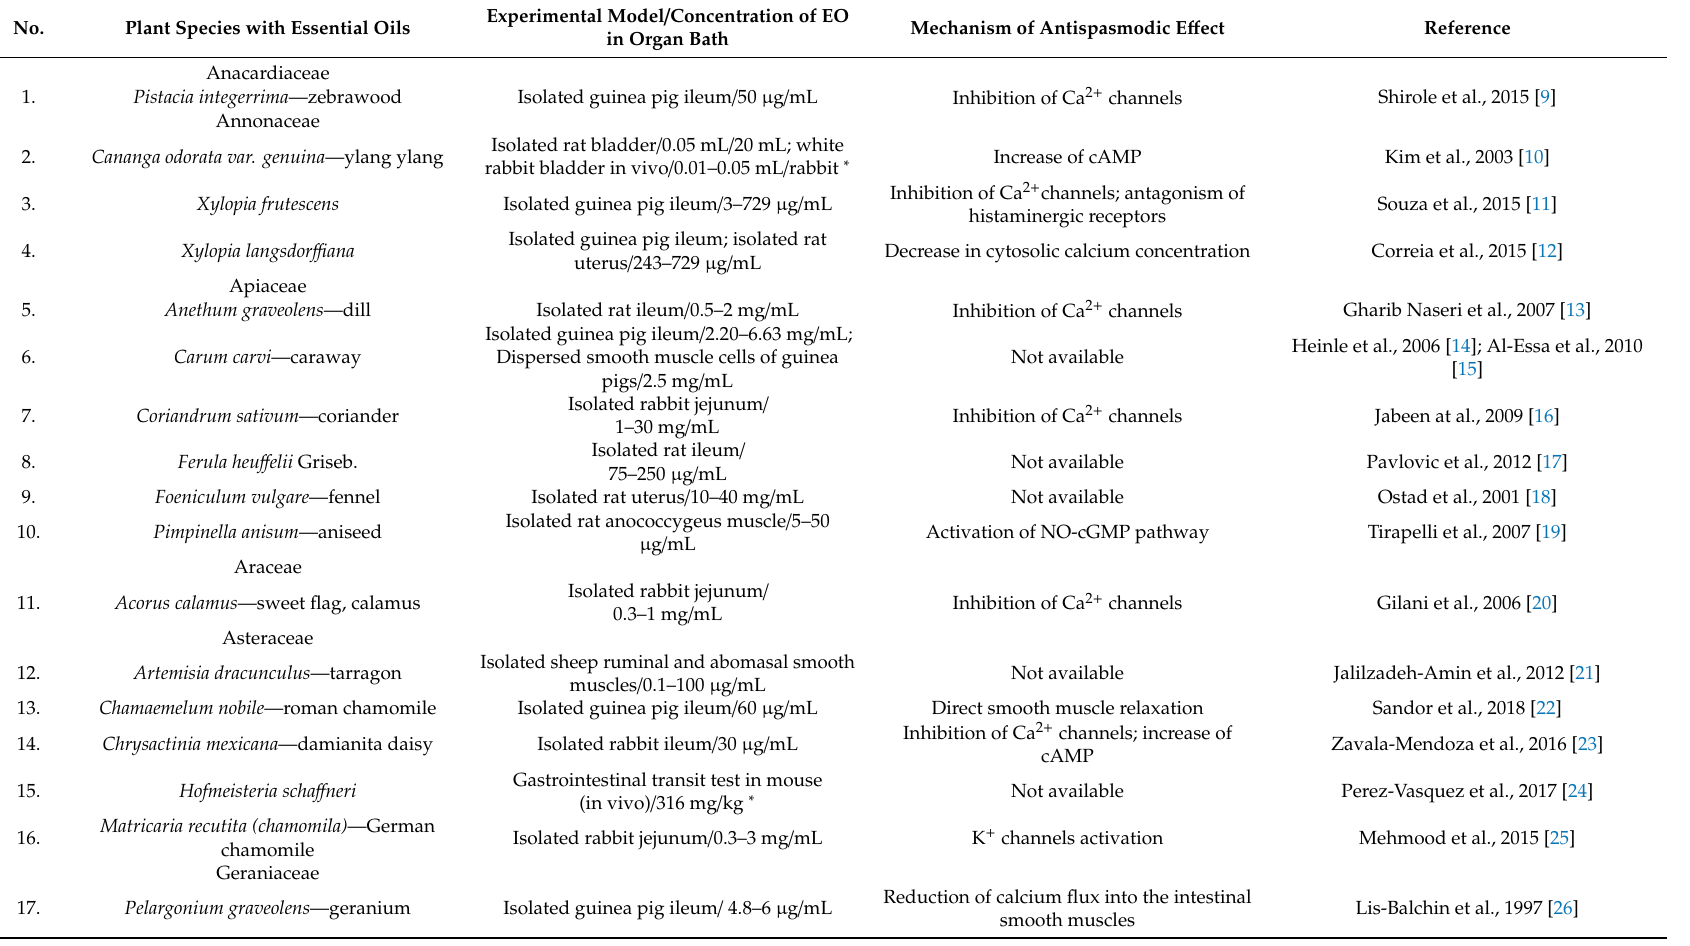
Table 1. Plant species containing essential oils with antispasmodic activity demonstrated in preclinical